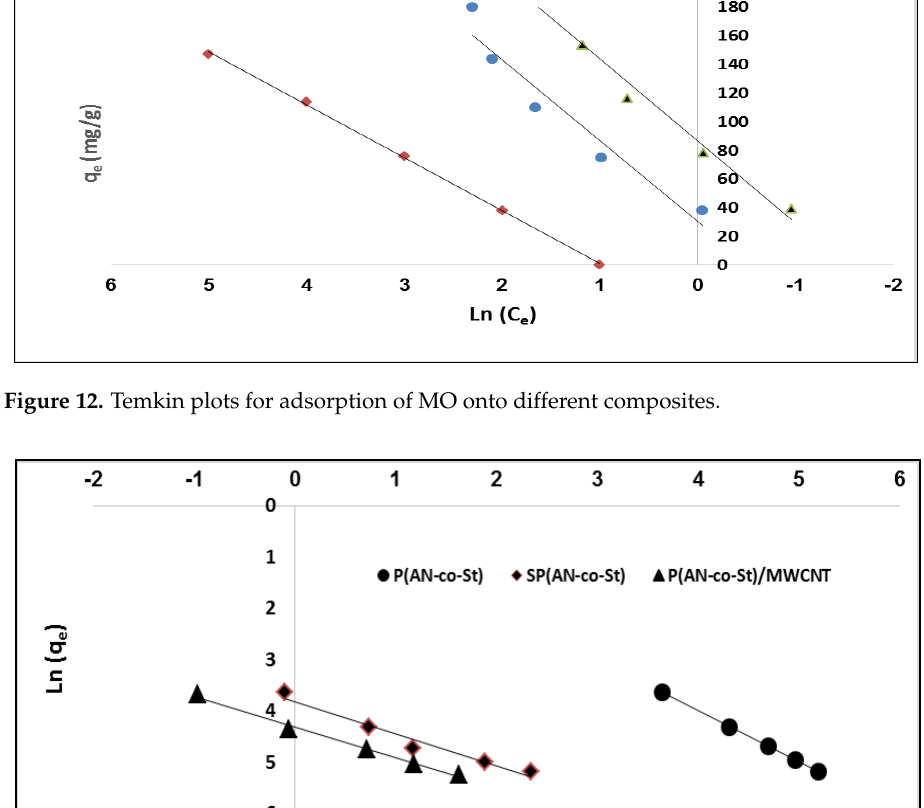
Figure 13. Halsey plots for removal of MO onto different composites.